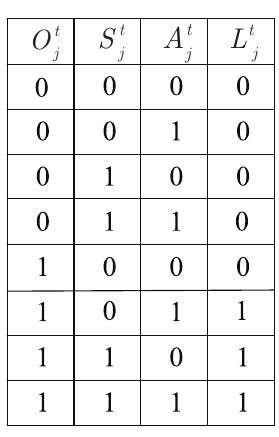
Figure 6. The truth table of state L t